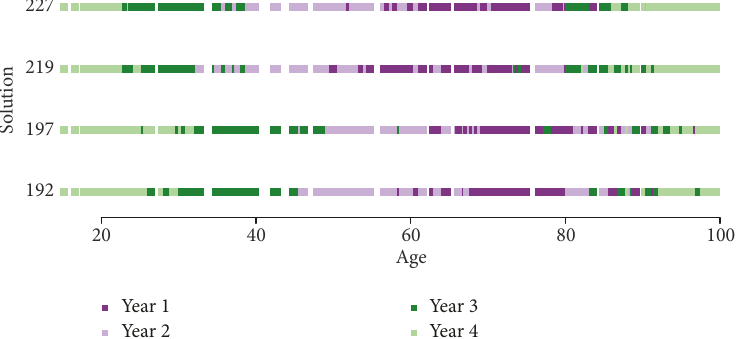
Figure 12: Consumption pattern, displayed by current age distribution, for the four most promising solutions selected based on the mixture plot in Figure 10. The coloring of each unit indicates the time period in which the strategy assigns the unit to be used (dark purple = Year 1; light purple = Year 2; dark green = Year 3; light green = Year